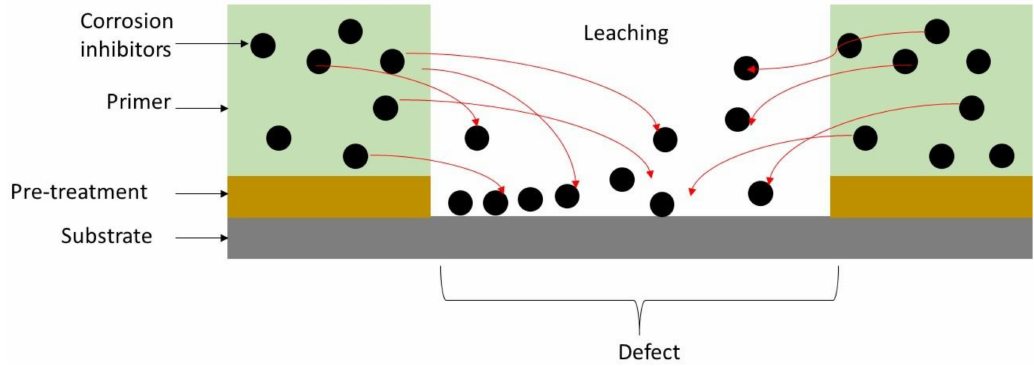
Figure 5. Schematic representation of the corrosion inhibitors leaching from the